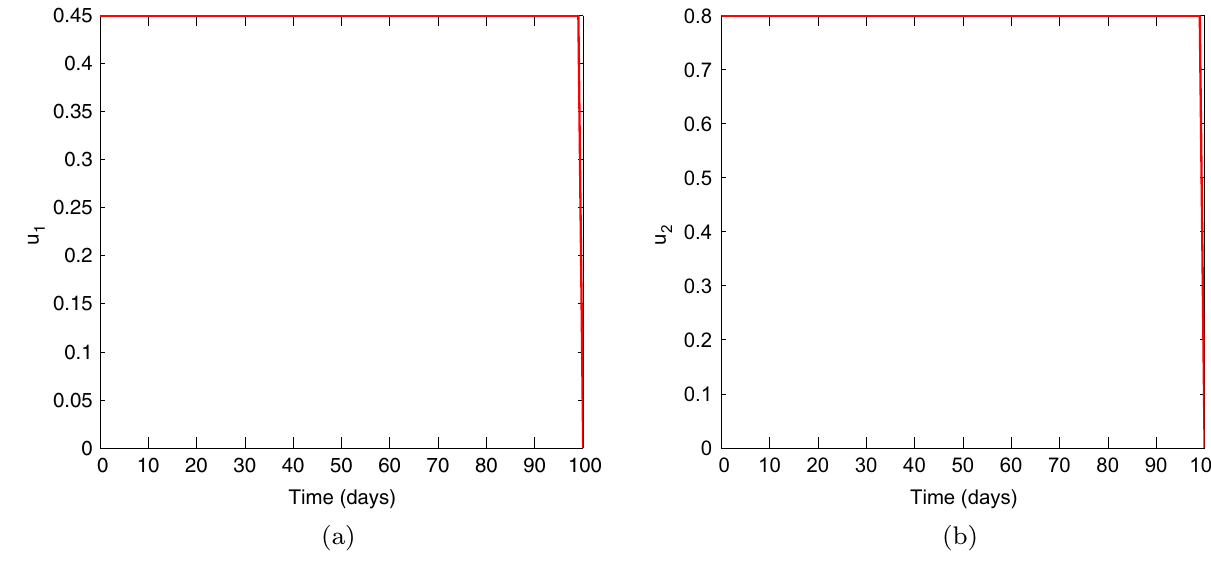
Figure 6. The control profile for case 1: ( a ) Patch 1; and ( b ) Patch 2.